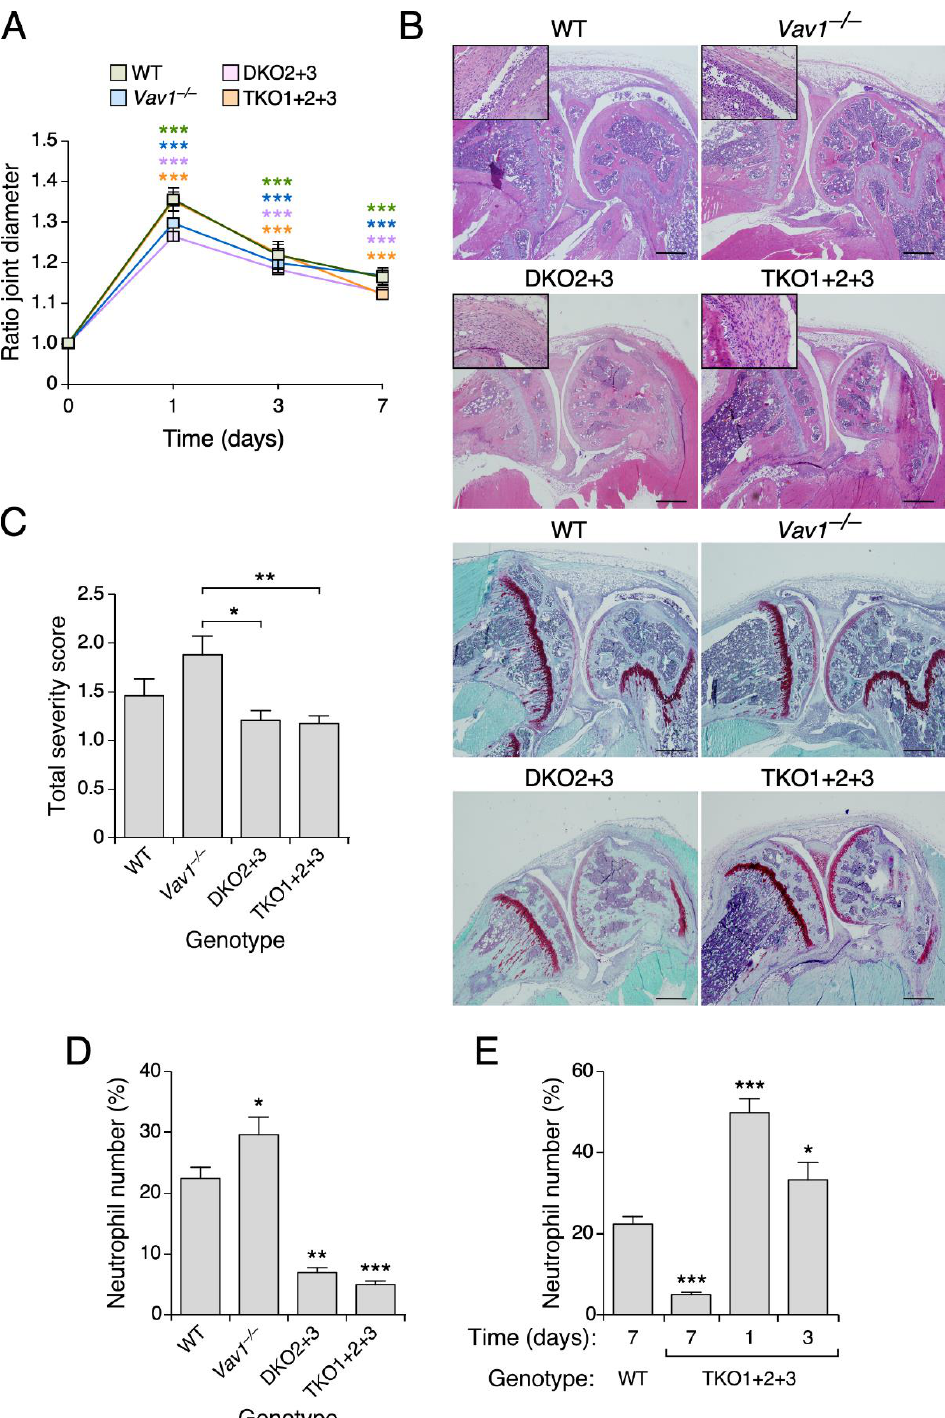
Figure 4. The Vav family is important for sustained inflammatory responses during Zymosan A-induced arthritis. ( A ) Evolution of the ratio joint diameter in animals of the indicated genotypes treated with Zymosan A. ( B ) Representative images of histological sections of knee joints from mice of the indicated genotypes that were stained with hematoxylin-eosin (four top panels) and Safranin-O Fast Green (four bottom panels). Scale bar, 500 µm. Insets show a higher magnification of the synovial tissue present in the joint section of each appropriate panel. ( C ) Histological scores for arthritis severity obtained by evaluating hyperplasia, inflammation and cartilage damage 7 days after the intra-articular injection of Zymosan A. ( D ) Quantification of the neutrophils present in the synovium (expressed as the percentage of neutrophils